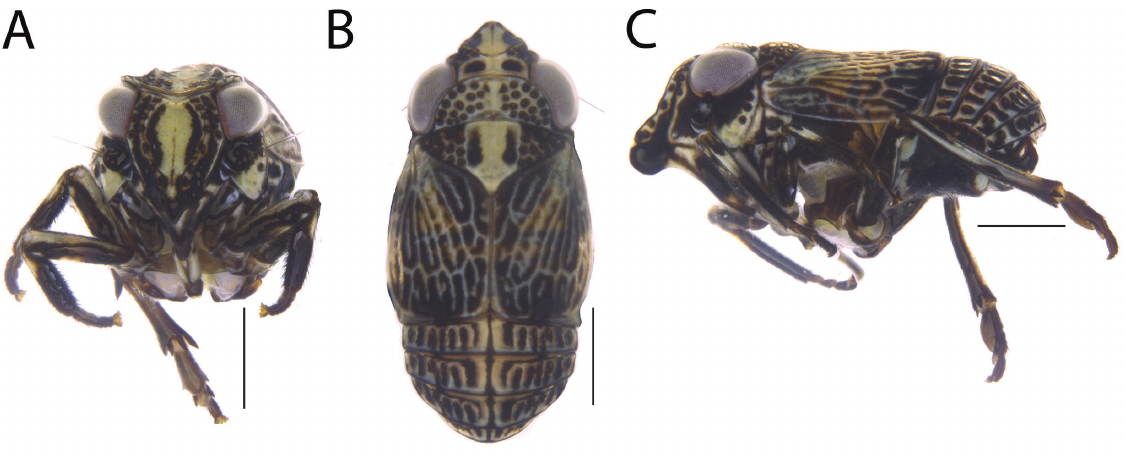
Fig. 11. Habitus of Fitchiella brachyrhina sp. nov., ♂, holotype (INHS). A . Frontal view. B . Dorsal view. C . Lateral view. Scale bars = 0.5